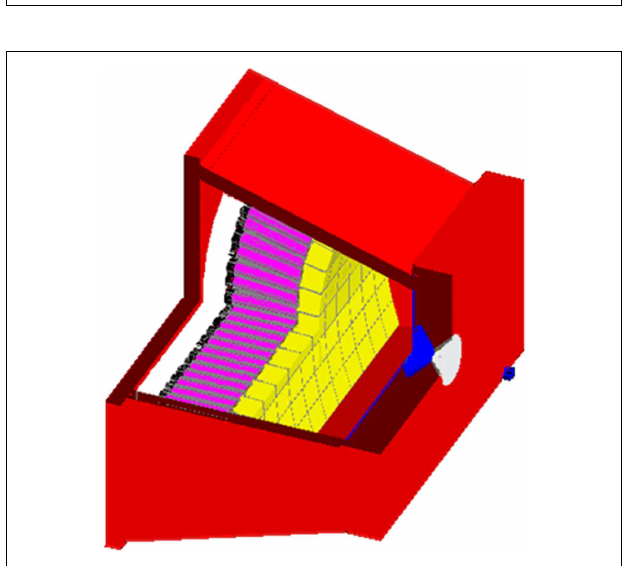
FIGURE 7 | Gate modeling of the prototype made of 7 × 11 BGO-blocks coming from a retired Exact HR + PET and equipped with a pinhole collimator (5cm-thick lead front plate, 8mm-aperture diameter) . From right to left: blue: 1cm-thick perpex surrounding the 90 Y point source, red: lead housing, white: tungsten outer conical insert, blue: tin inner conical insert and 2mm-thick layer, yellow: 30mm-thick BG, gray: mu-metal, purple: cathode–dynodes cascade (PMT pyrex housing walls were set no visible), black: PMT plastic sockets, white: perpex modeling the